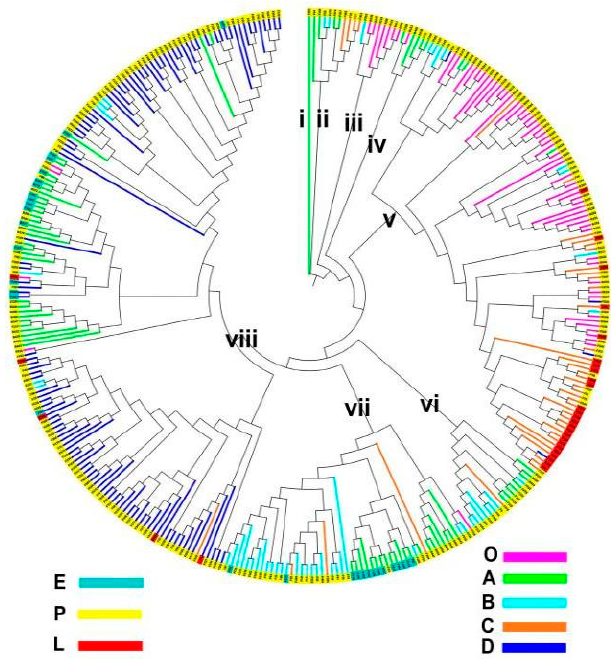
Figure 2. Neighbor-joining tree of 354 soybean varieties of the WSGP based on SNPLDB markers. “O” represents the varieties from the center of origin in both Huang ‐ Huai River Valleys (HCHN) and Chang ‐ jiang River Valleys and its south (SCHN). “A” represents the varieties from Northeast China (NCHN), Far ‐ East Russia (RUFE) and southern Sweden (SSWE); “B” represents the varieties from the Korean peninsula (KORP) and Japan islands (JPAN); “C” represents the varieties from Southeast Asia (SEAS), South Asia (SASI) and Africa (AFRI); “D” represents the varieties from northern North America (NNAM), southern North America (SNAM) and Central and South America (CSAM). “E” represents the early MG set varieties (MG 000~0); “P” represents the primary MG set varieties (MG I~VII); “L” represents the late MG set varieties (MG VIII~X). Table 4. The frequency distribution of geographic and MG ‐ set subpopulations in 8 genotypic clus ‐ ters of world soybean germplasm population (WSGP).